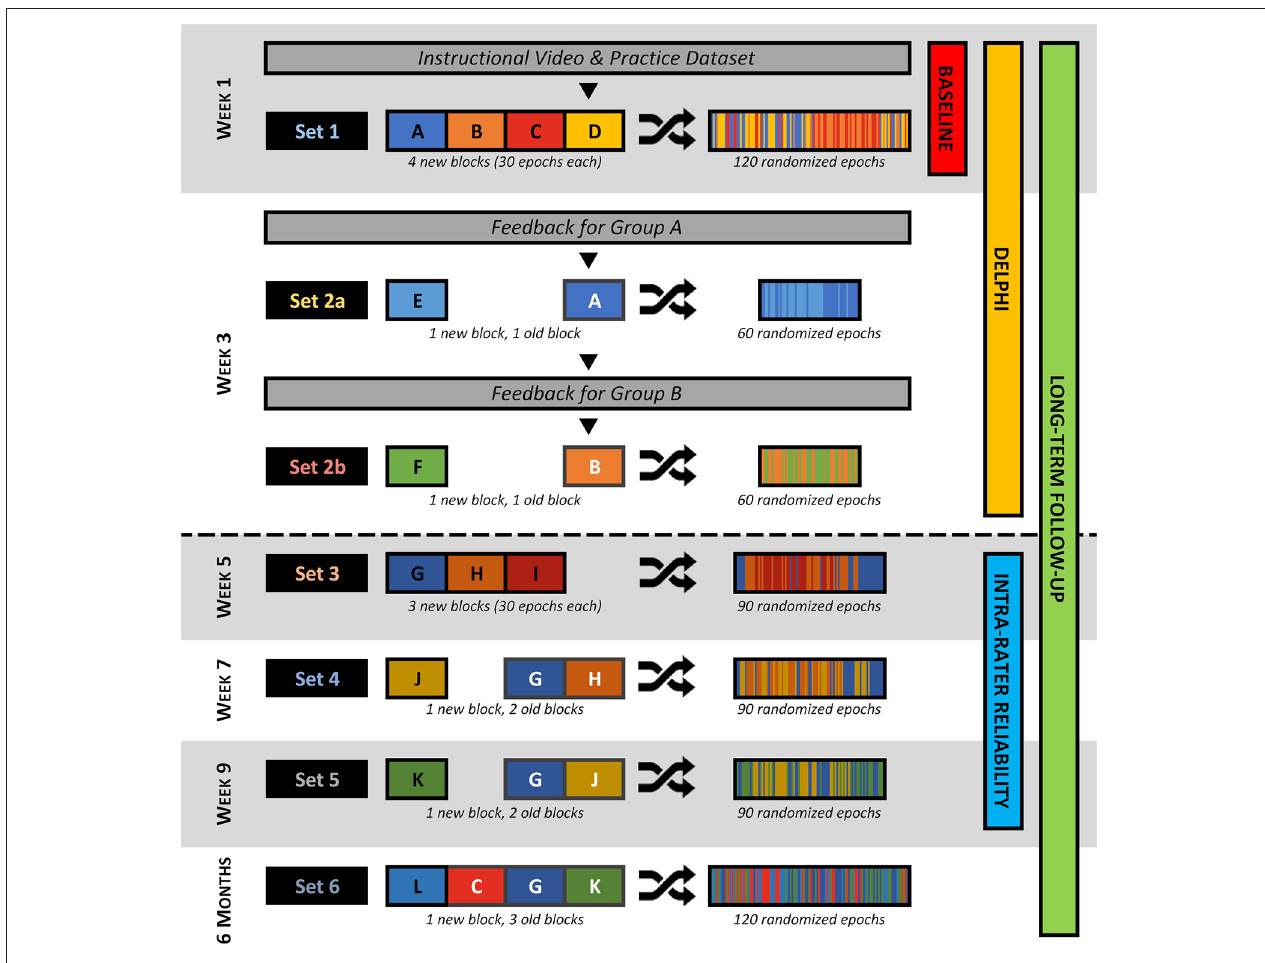
FIGURE 1 | Diagram outlining the flow of the study. At the start, reviewers were given an instructional video and practice dataset. After this, each week, reviewers were presented with one or two datasets, each comprised of two to four “blocks” of data. These blocks may be new (black text and outline) or repeated from a previous dataset (white text and outline), but all consist of exactly 30 epochs (1 epoch per event type per patient) that were randomized. During Week 3, reviewers were presented with feedback before or after they complete Dataset 2a depending on which group they are randomized to. The corresponding phase(s) of the study are indicated on the right-hand side—those above the dashed line are included in the present